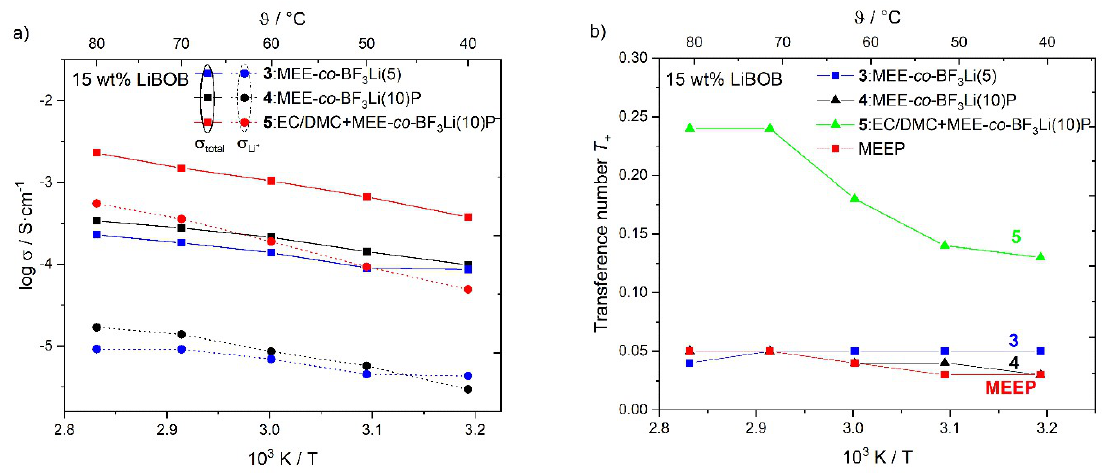
Figure 5. ( a ) Arrhenius diagram for cross-linked polymer 3 , 4 , and 5 with 15 wt % LiBOB showing the total and partial lithium conductivity ( σ total and σ Li + ). ( b ) Corresponding lithium transference numbers of 3 , 4 , 5 , and MEEP.